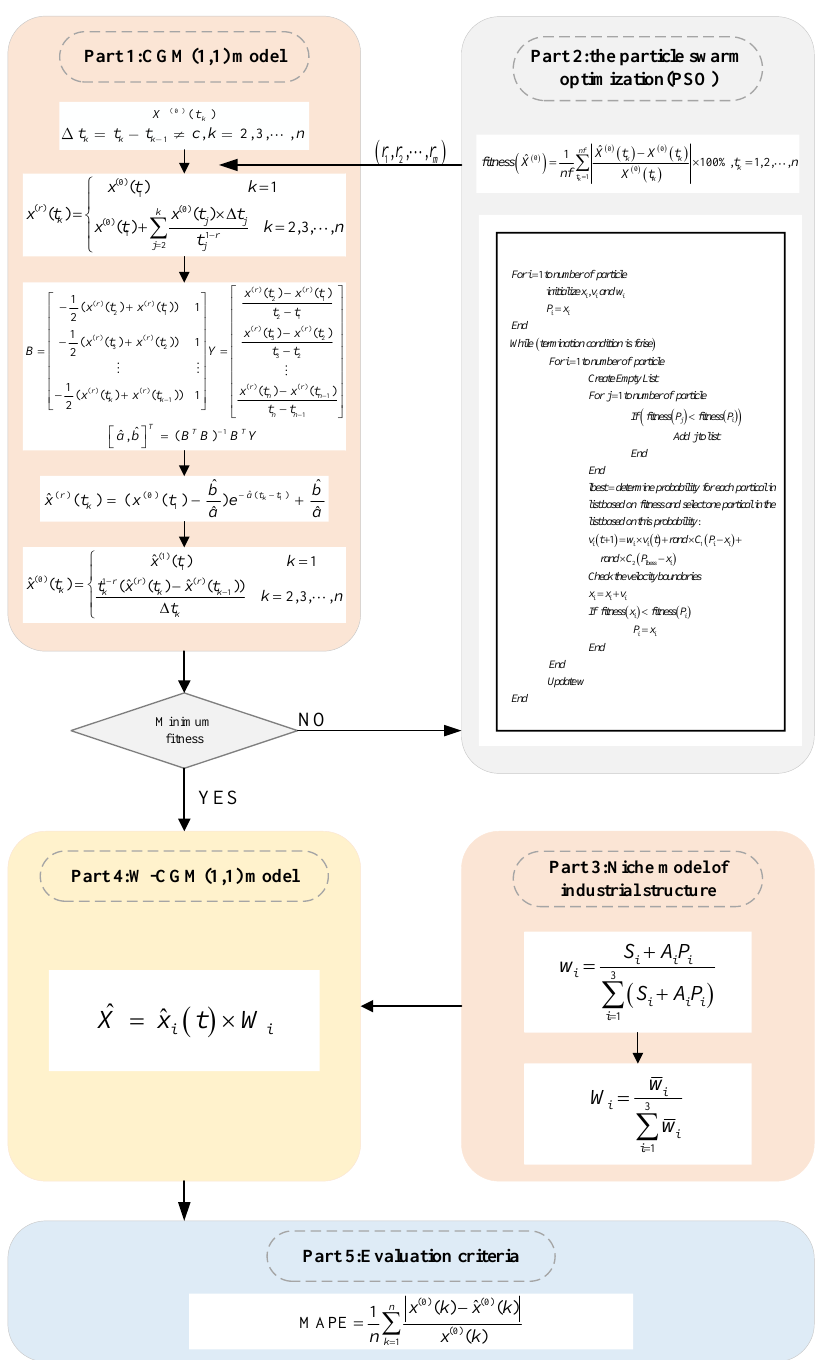
Figure 2. The forecasting process of water consumption.